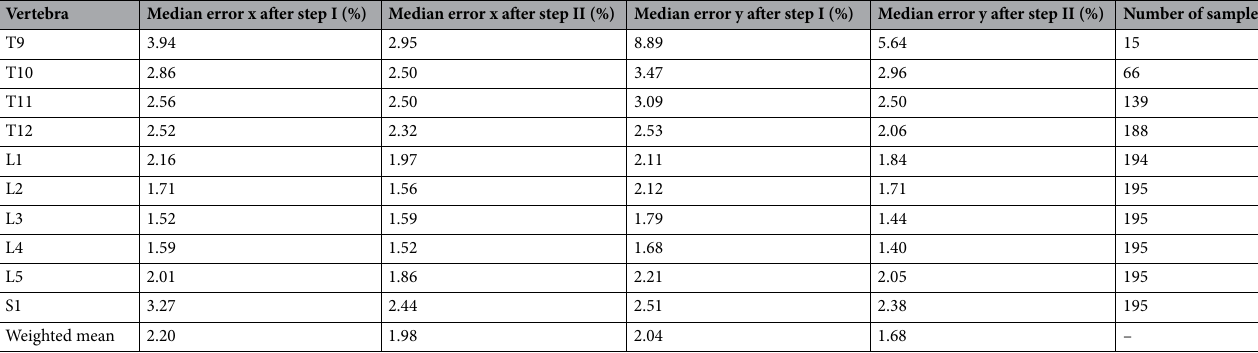
Table 1. Errors calculated for the single vertebrae. The first 2 columns report the median of the absolute error related to the x and y vertebra dimension (Eqs. 1 and 2). The last row sums up the results to have an overall evaluation (Eqs. 5 and 6).